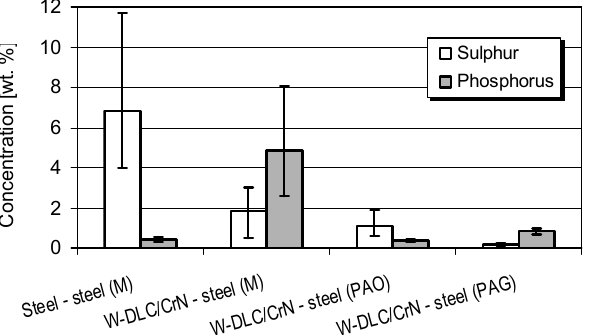
Figure 13. Quantitative results of the EDS analysis of the sulfur and phosphorus from the worn surfaces of the pins.